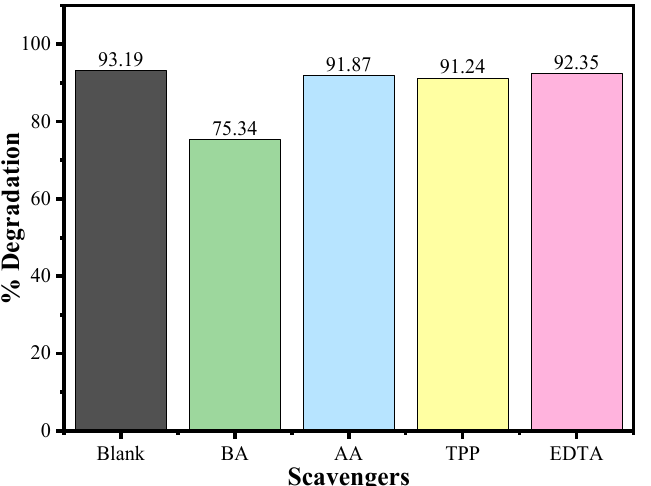
Figure 11. Photodegradation of paracetamol by NiWO 4 /CoWO 4 NC in the presence of different scav- engers.